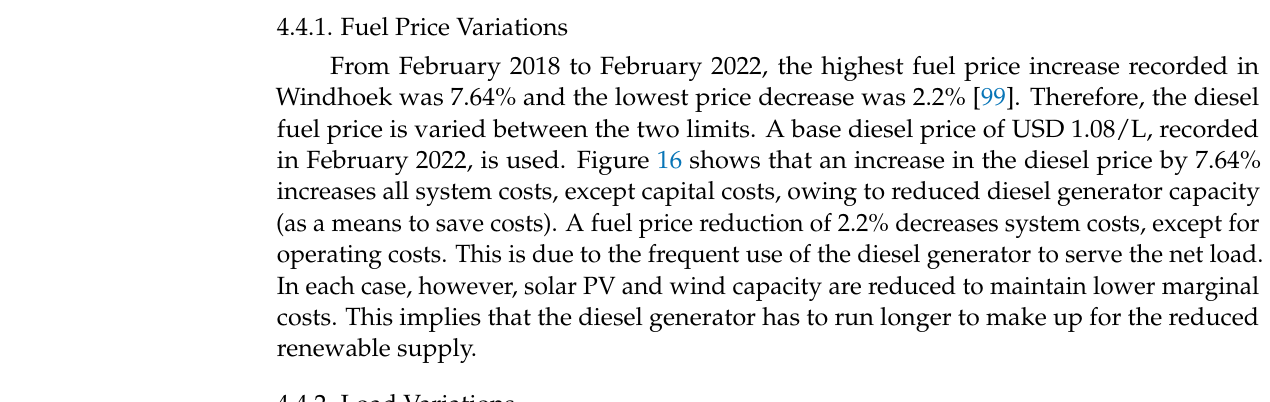
* Abbreviations used in this table are listed below: 1 Capacities for Solar PV|Wind|Diesel|Battery|Converter (whichever is applicable). 2 DS—Dispatching Strategy, 3 EP—Energy Production (kWh/yr), 4